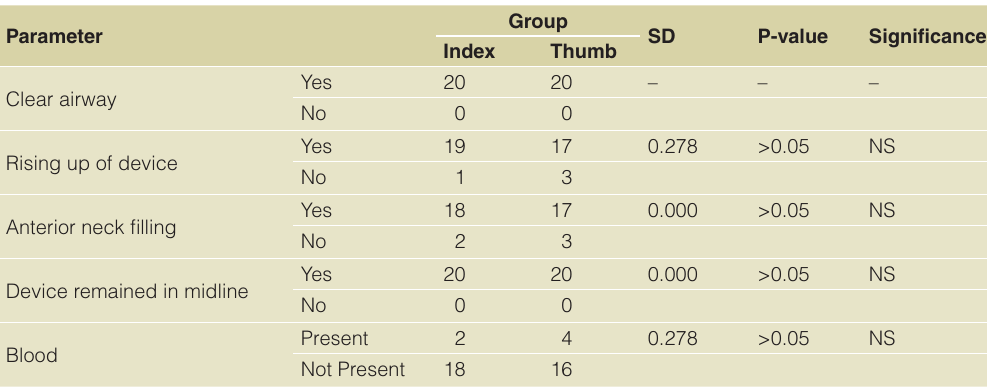
Table 3. Insertion